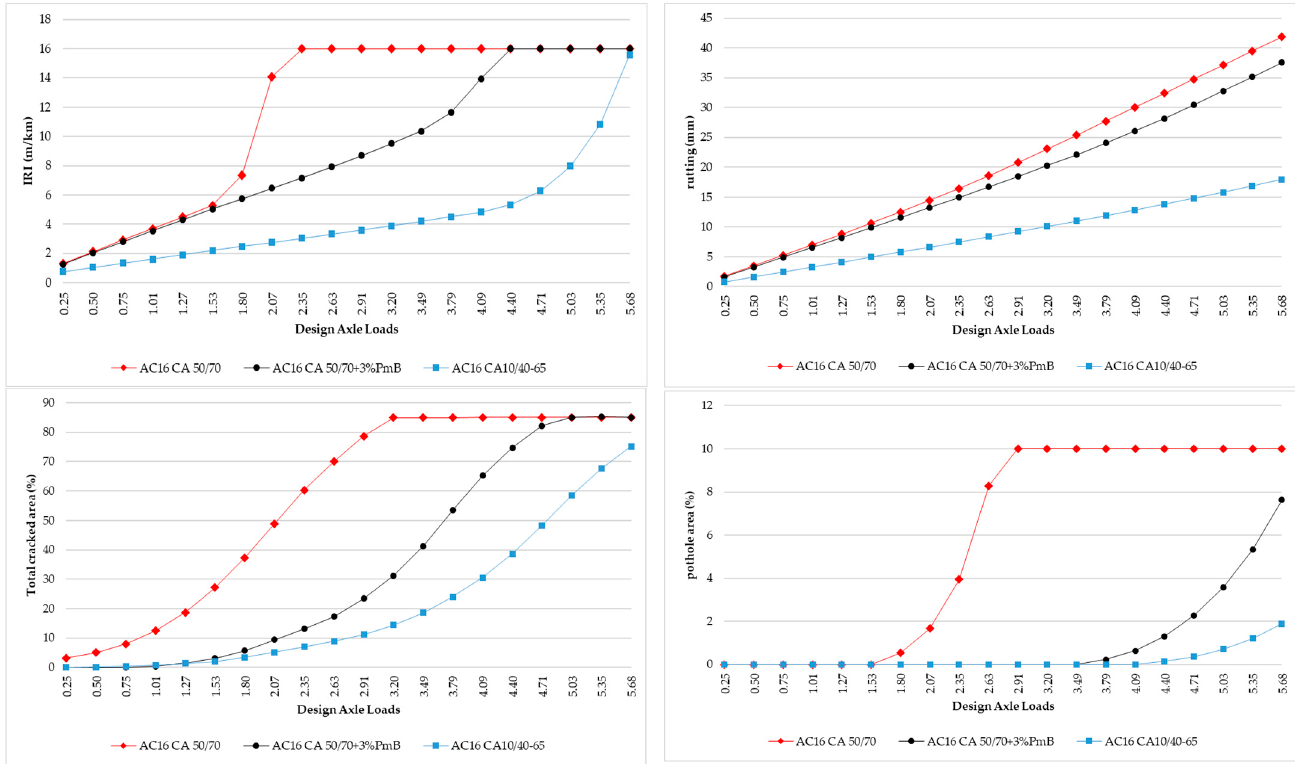
Figure 6. Pavement performance and life cycle